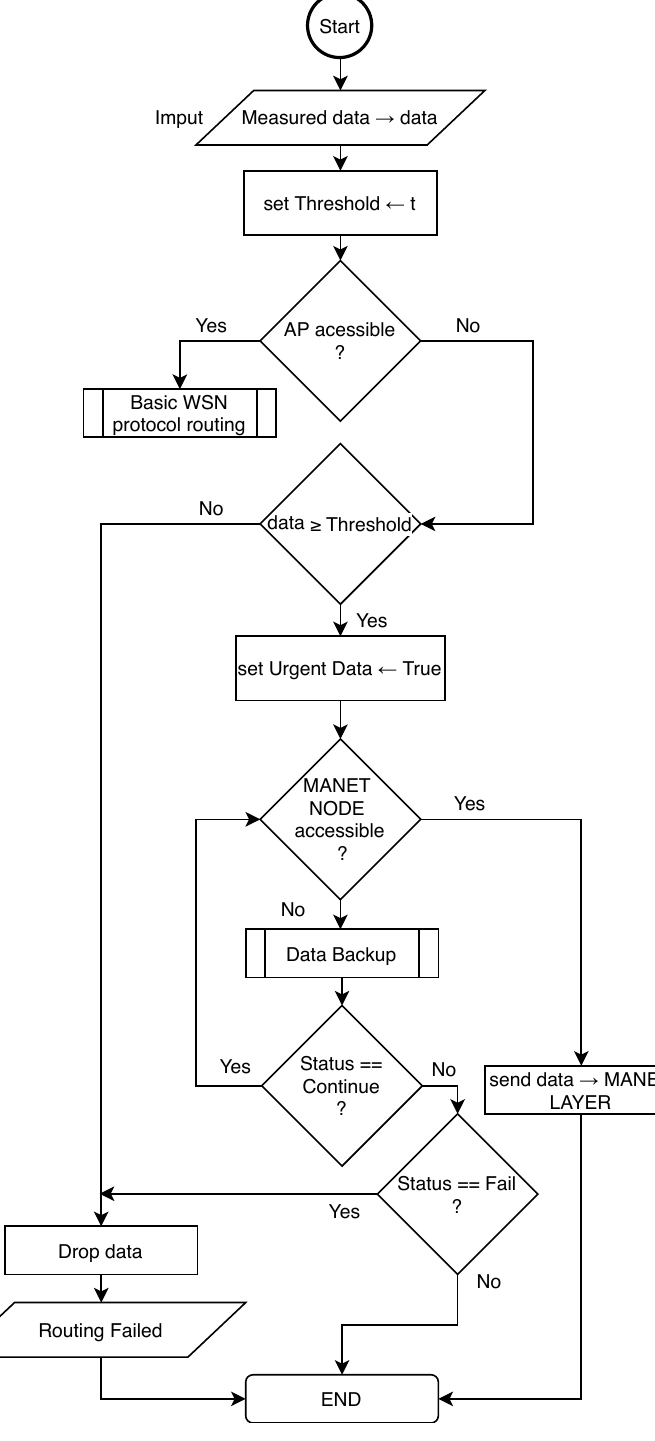
Figure 9. The WSN Layer routing